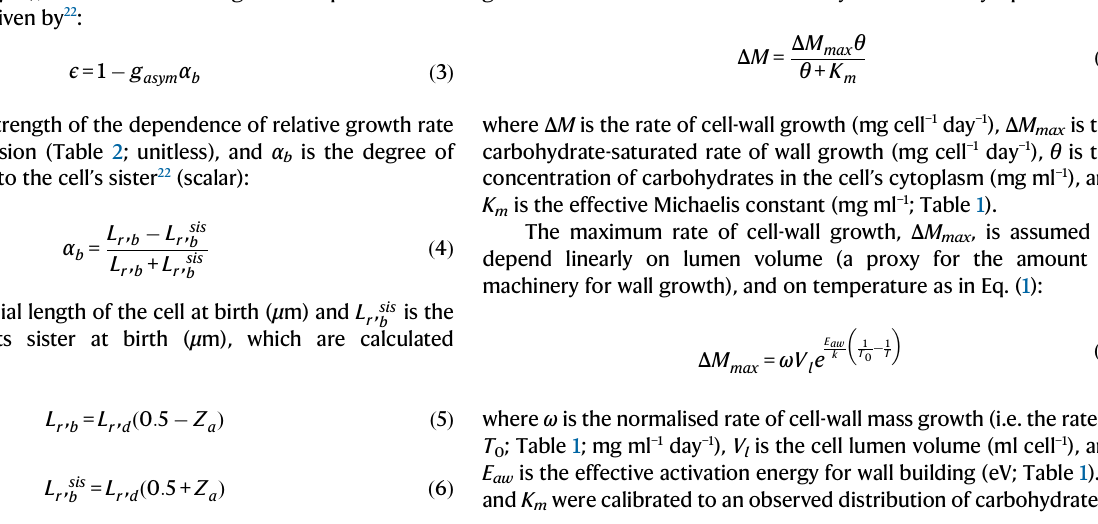
(Table 2; − 0.49 ≤ Z a ≤ 0.49 for numerical stability).